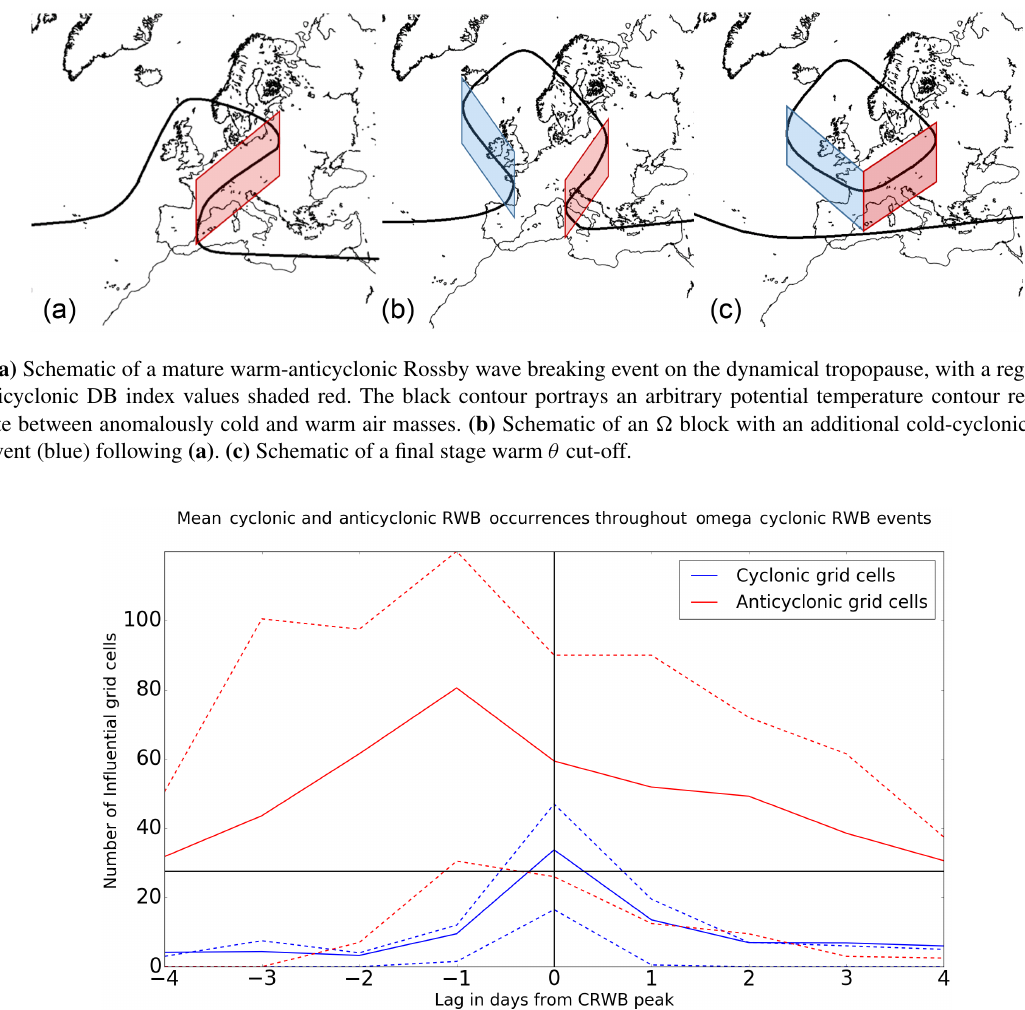
Figure 7. Grid points displaying RWB of (anti)cyclonic tendency in (red) blue with time in days relative to the peak of northeast Atlantic– European CRWB events. Solid lines represent the mean grid point count, while the dashed lines represent the 25th and 75th percentile of counts for all events. In the formation of an (cid:127) block an ACRWB precursor is required. Of the 35 CRWB events detected within the northeast Atlantic–European sector throughout January 1999–December 2008, 33 fulfilled the criteria of prior ACRWB occurrence. All CRWB events displayed in Fig. 7 include an ACRWB precursor within the 4 days leading up to and including the CRWB event. The black horizontal line represents the mean ACRWB count (30.07 grid points) throughout the